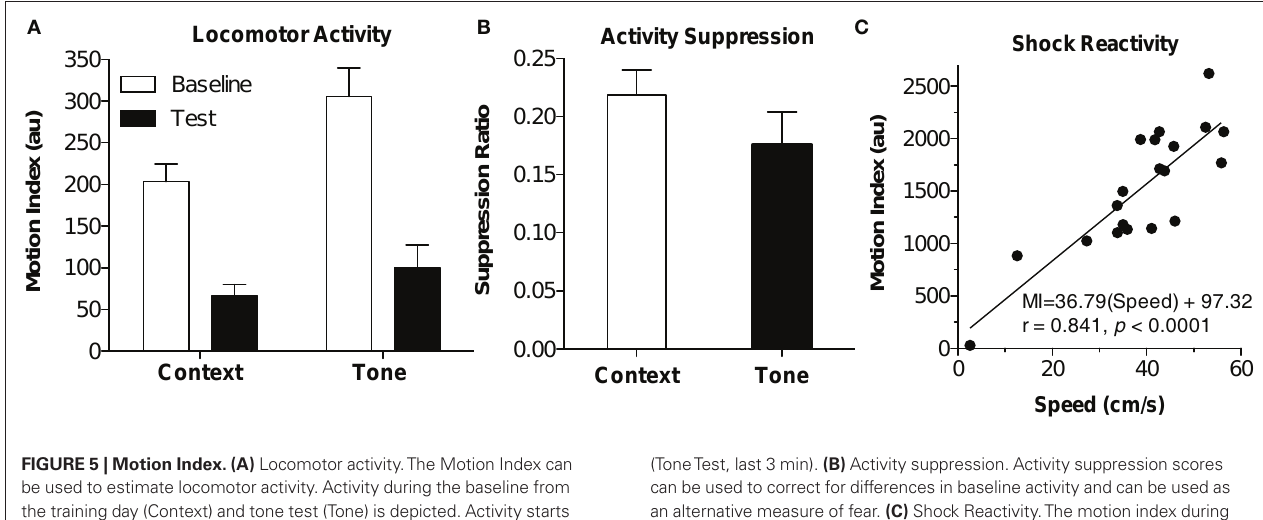
Figure 5 | Motion index. (A) Locomotor activity. The Motion Index can be used to estimate locomotor activity. Activity during the baseline from the training day (Context) and tone test (Tone) is depicted. Activity starts high (baseline, first 2 min) dramatically drops after conditioning (Test, last 3 min). Activity is higher in the NIR-only light during the tone test (Tone Baseline, first two min), and drops when the tone is played